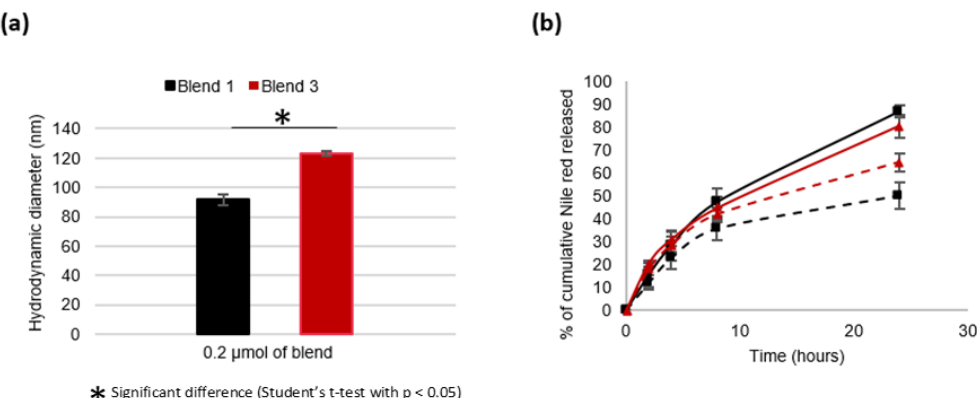
Figure 8. Impact of PLA chain length on the properties and characteristics of nanocarriers. ( a ) Hydro- dynamic diameter D H . ( b ) Kinetics of the in vitro release of Nile red at 37 ◦ C from the NCs made of 0.2 µ mol of blend: B1 (black square) or B3 (red triangle); without GSH (dashed lines); in the presence of 10 mM GSH (continuous line).